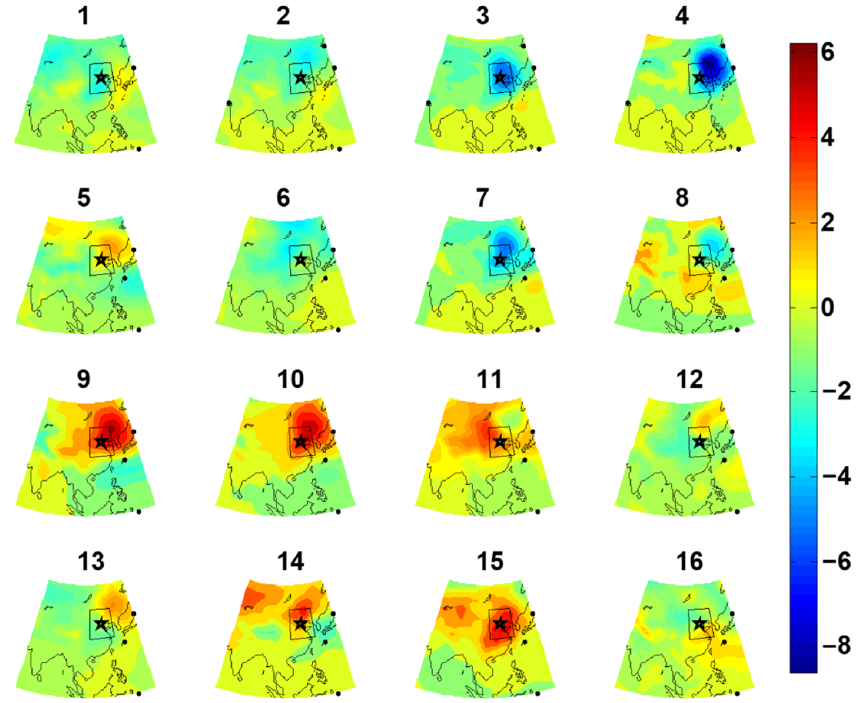
Figure 9. Distribution of sea level pressure field (hPa) for 16 SOM nodes corresponding to the training results.